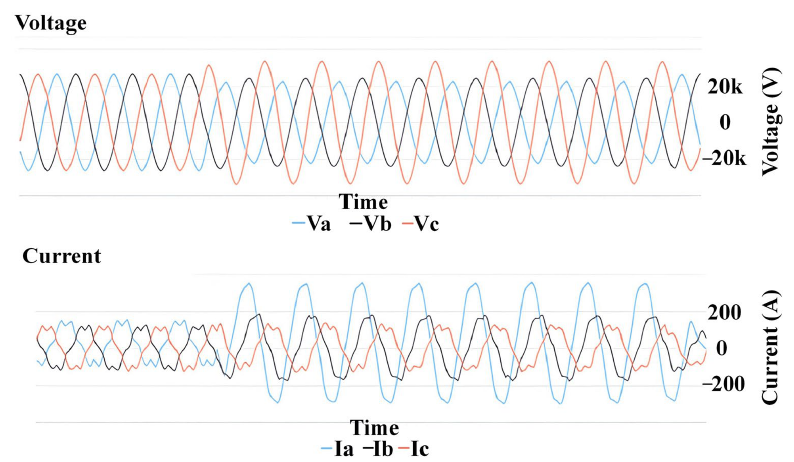
Figure A5. Current and voltage waveform recorded by PQ analyzer during the voltage sag for event 5.